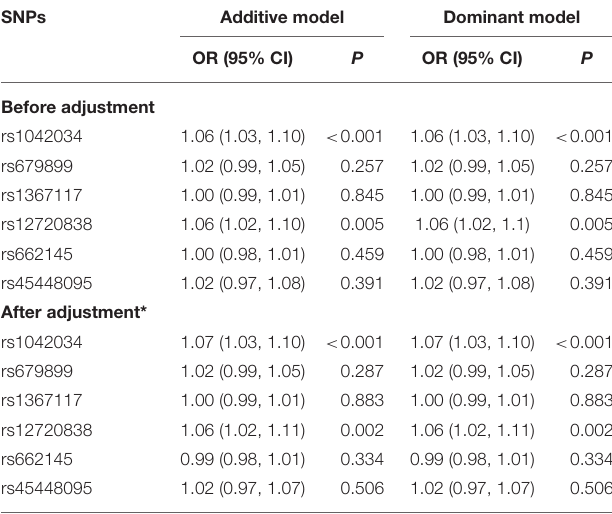
TABLE 3 | Risk prediction of 8 studied polymorphisms for diabetic kidney disease under both additive and dominant models. SNPs Additive model Dominant model